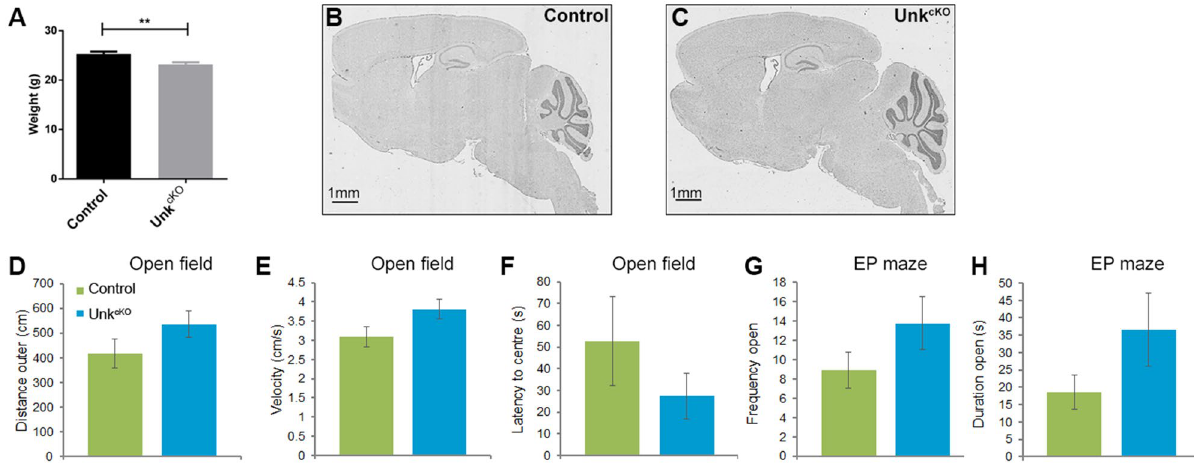
Figure 5. Unk cKO mice have normal locomotor activity and show a trend towards decreased anxiety . ( A ) Body weight of control and Unk cKO mice at 12 weeks. ( B , C ) Sagittal sections of control ( B ) and Unk cKO ( C ) mice at P20 stained with haemotoxylin and eosin. ( D , E ) Open field test measure of distance ( D ) and velocity ( E ) of movement in the outer ring of the arena. ( F ) Open field test, latency to centre. ( G , H ) Elevated plus (EP) maze test, number of entries to open arms ( E ), time spent in open arms ( H ). Control n = 11, Unk cKO n = 8. Data are presented as mean ± SEM. Students t-test, ** p < 0.01 compared to